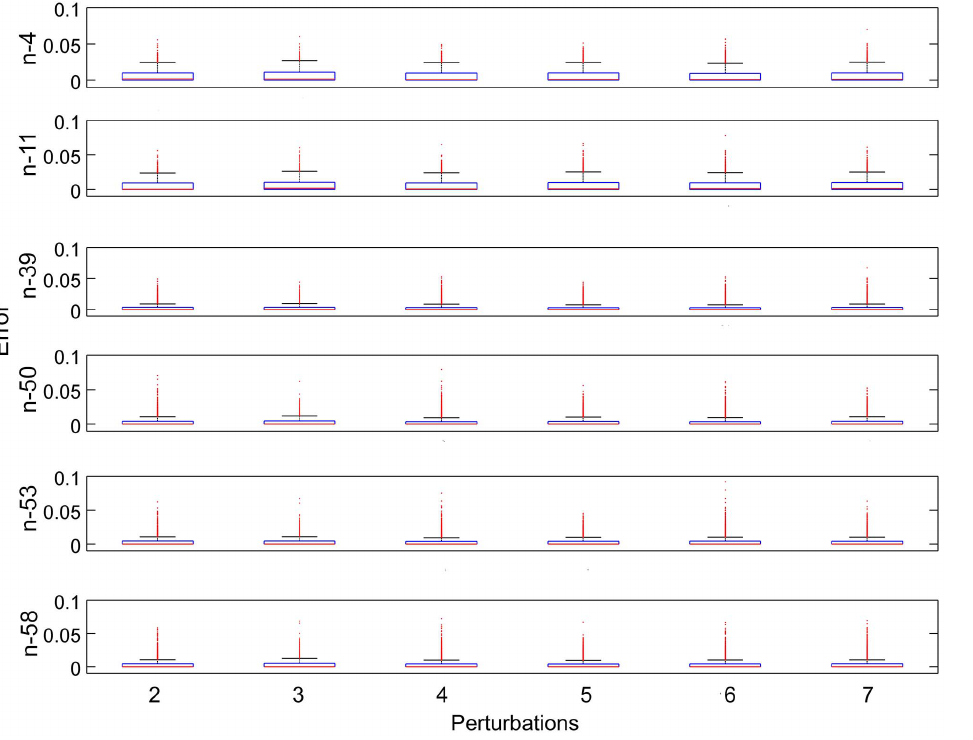
Figure 3. Boxplots of RMSE of inferred concentrations. The 6 subplots depict the results of applying inference method to 6 benchmark networks. For each network, its inference results under different numbers of perturbations, varying from 2 to 7, are shown individually. The median values of RMSE approximate to 0 and the 3 rd quartile values range from 0.0031 to 0.011.